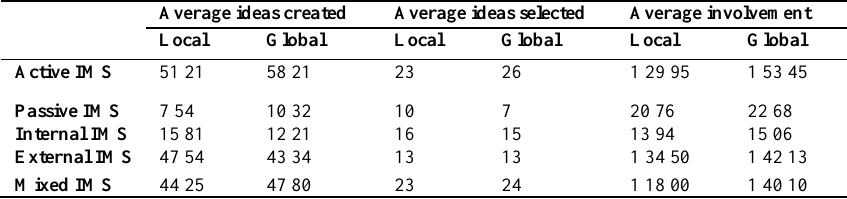
Table 2. Average numbers of ideas created, selected and involvement (numbers)